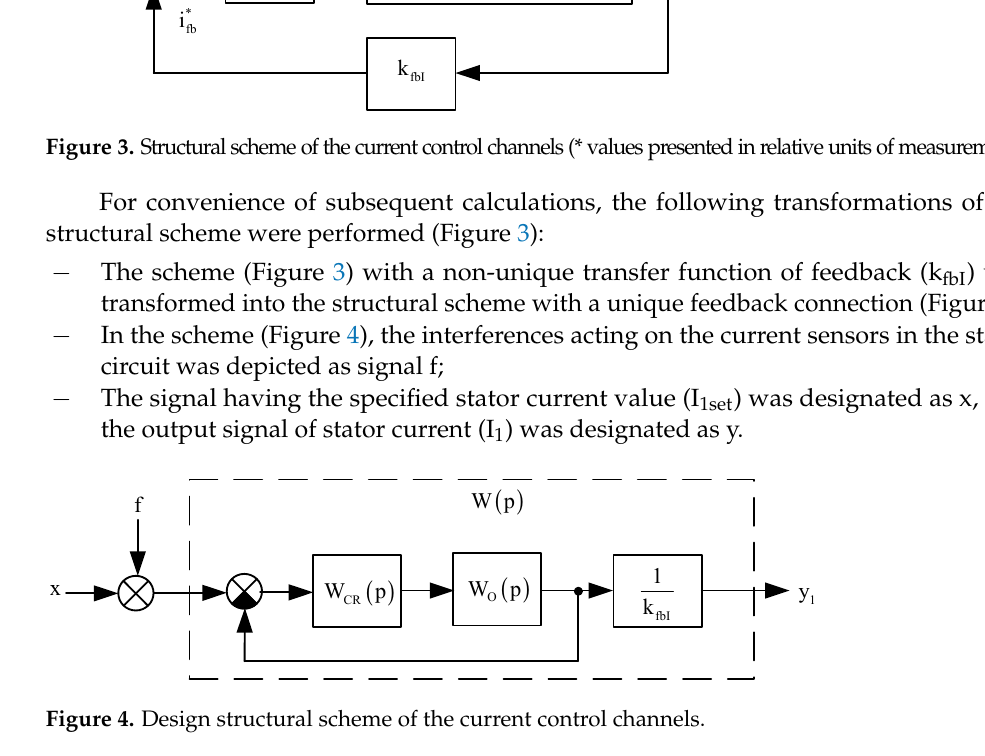
Figure 3. Structural scheme of the current control channels (* values presented in relative units of measurement).